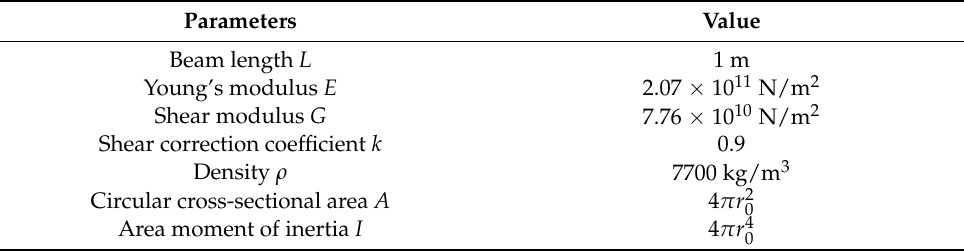
Table 1. Parameters and properties of the